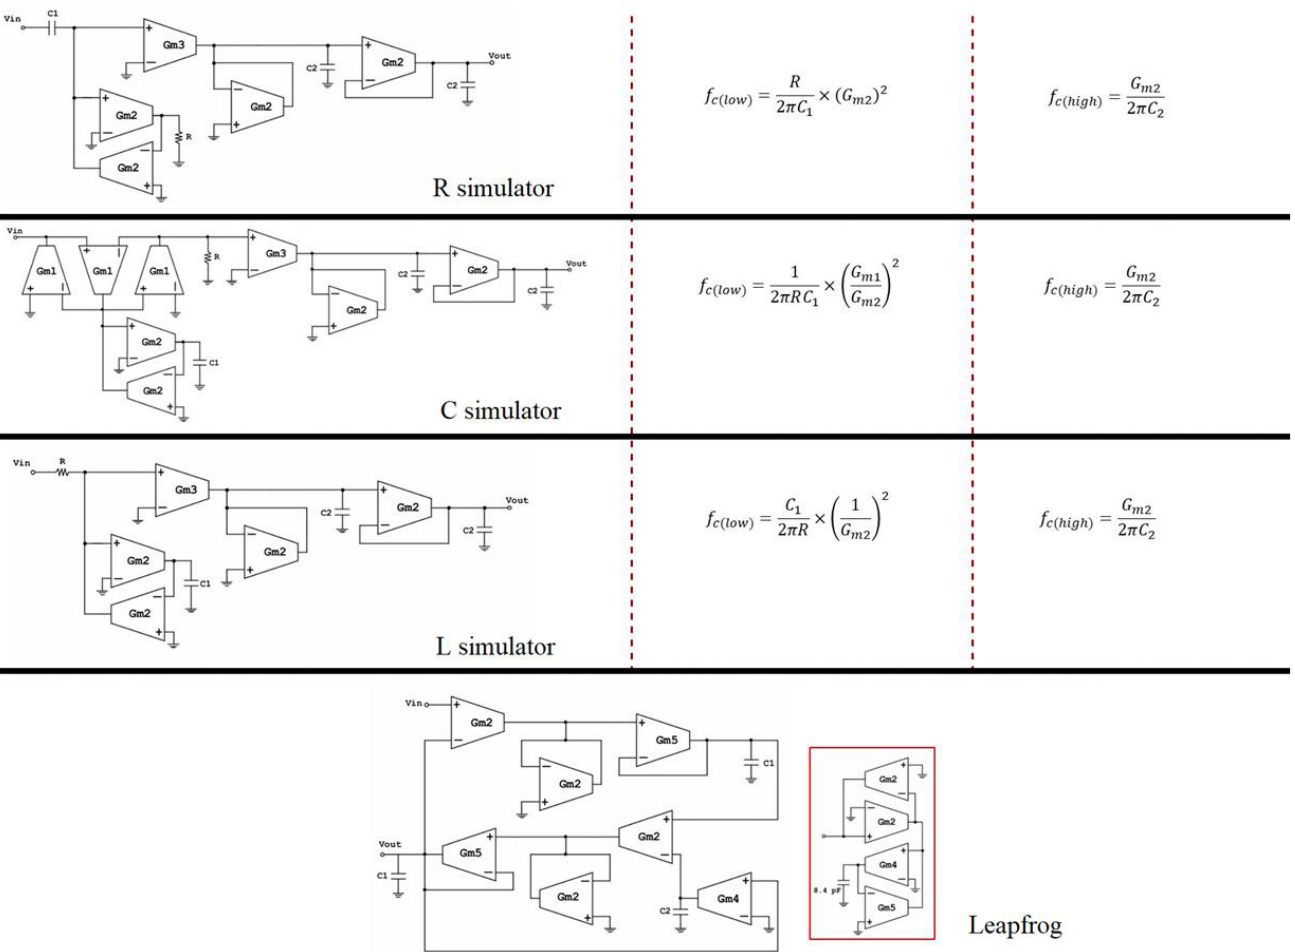
Figure 11. Final versions of the filter designs and their respective updated high-pass and low-pass cutoff frequency